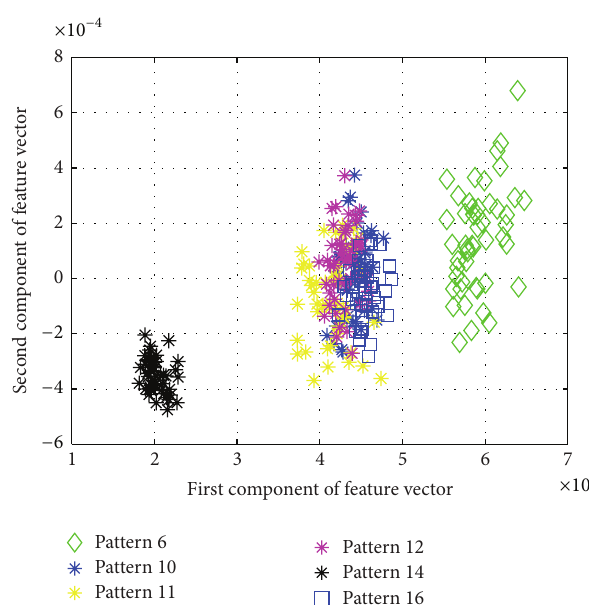
Figure 21: The DWT feature vectors of data patterns in second scenario from sensor node 232.